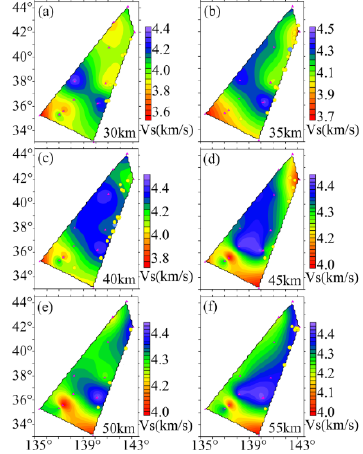
Figure 7: The same as Figure 6, but for the depth of 30 to 55km with 5km interval.